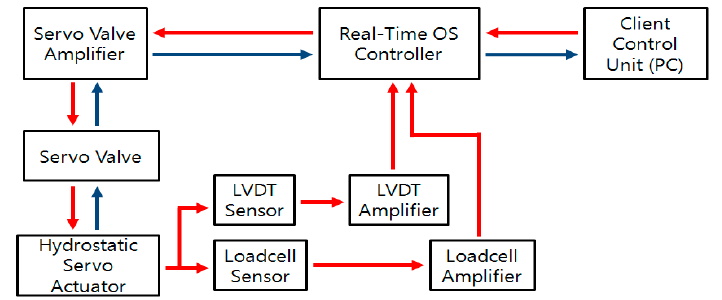
Figure 11. Real-time system block diagram.